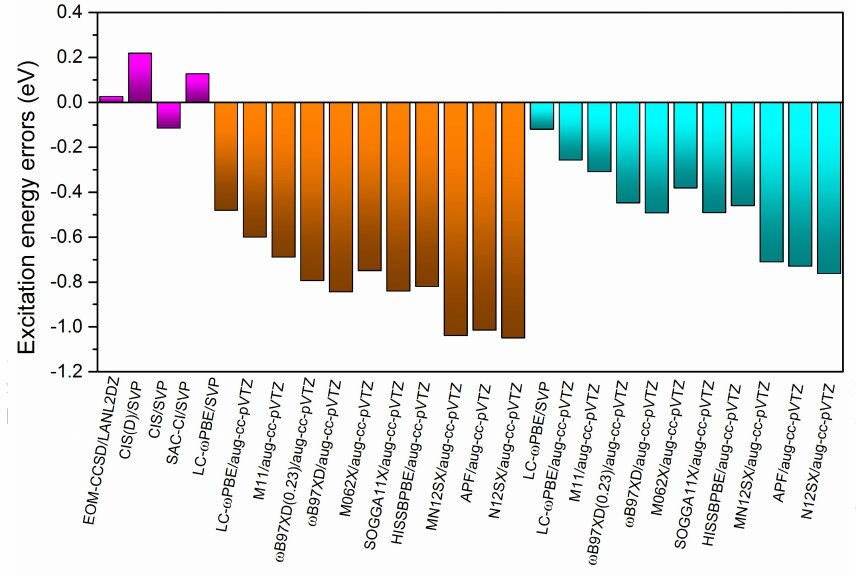
Figure 3. The calculated excitation energy errors relative to the EOM-CCSD/SVP benchmark result for the lowest singlet local excited state. The purple, brown, and blue regions represent the results of the ab initio, full TDDFT, and TDA-TDDFT methods,